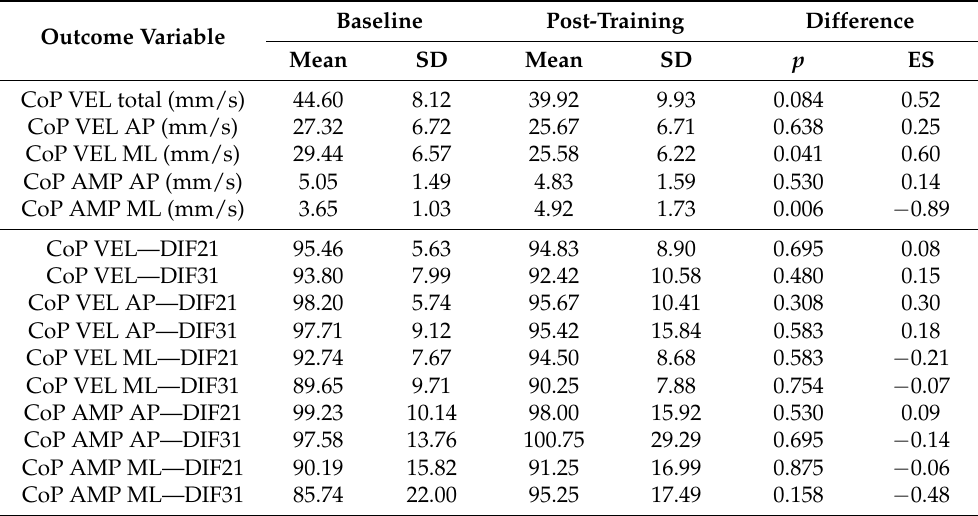
Table 3. The comparison of baseline and post-training results ( n =